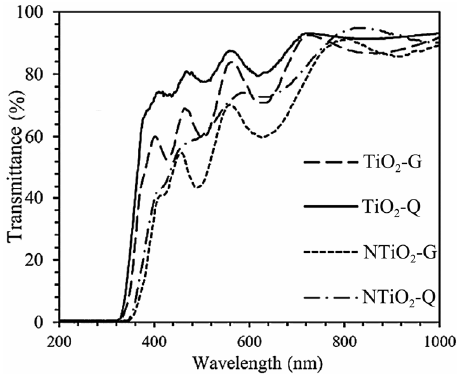
Fig. 6 Transmittance spectra of the prepared thin film samples.